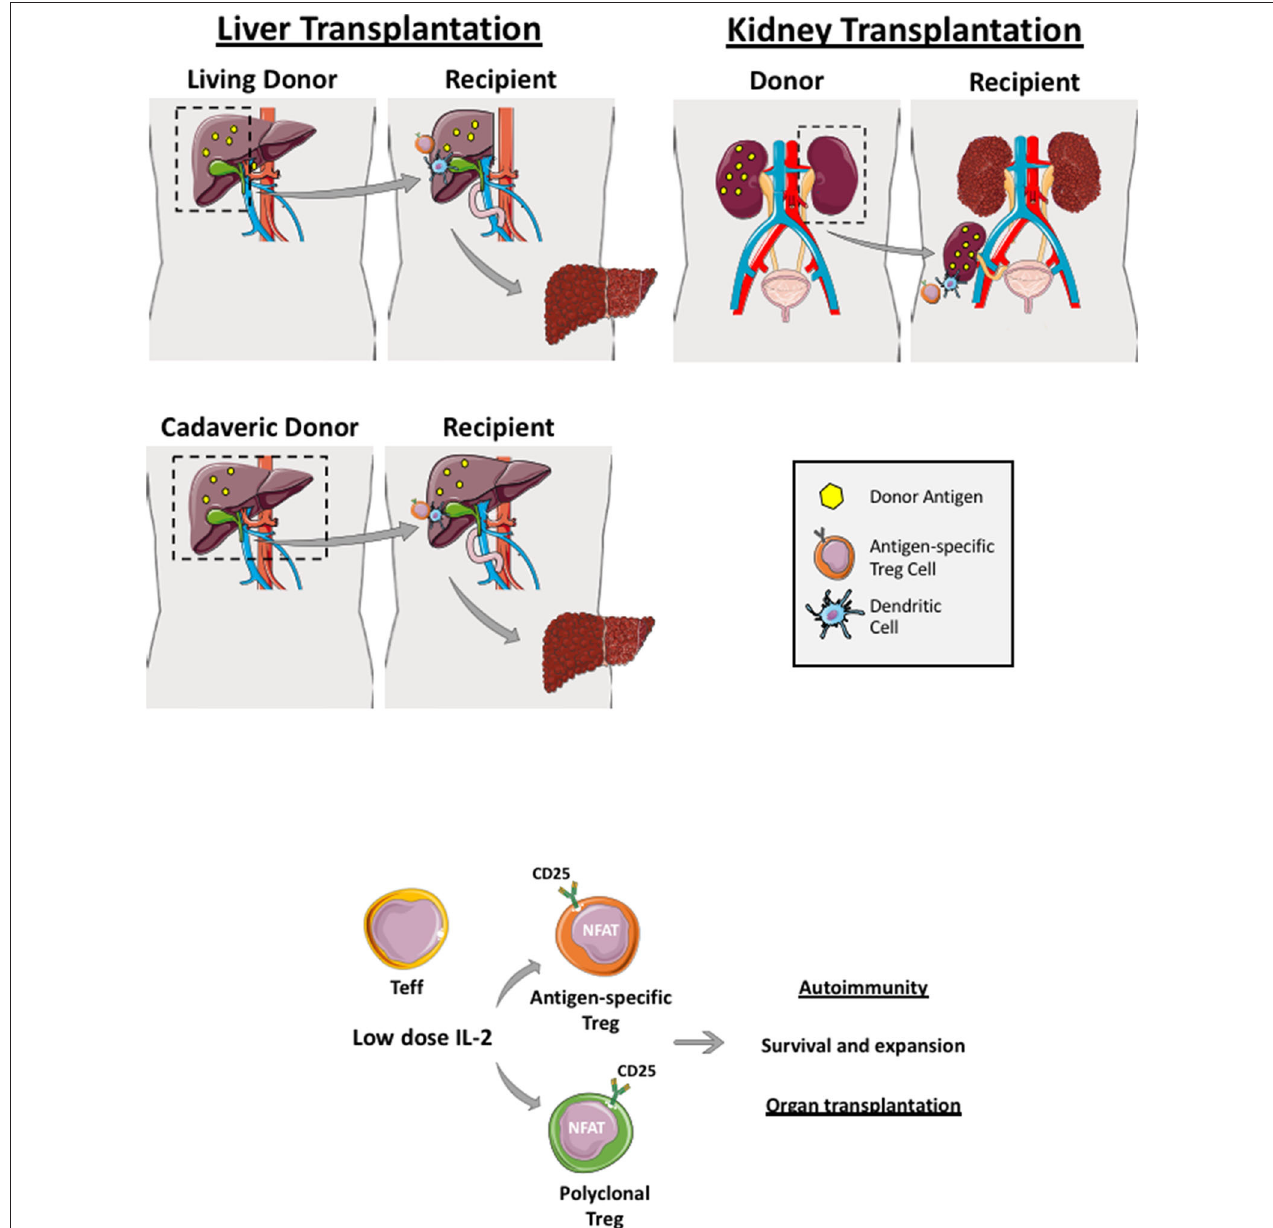
FIGURE 2 | Regulatory T cells in live and cadaveric liver transplant. Liver transplantation can be a living-related (right lobe graft- upper figure) or a cadaveric transplant (whole liver transplant—lower figure). Renal transplantation can also be cadaveric or a live donor allograft. If it is a living donor transplantation, antigen-specific Treg cells can be generated and expanded before transplantation whereby recipient Treg cells are co-cultured with donor dendritic cells, which are primed with donor antigens (yellow dots). Both polyclonal and antigen-specific Treg cells proliferate and function via utilizing interleukin-2 as Treg highly express IL-2 receptor, CD25. These generated Treg cells are applied in both autoimmune disease and transplantation clinical